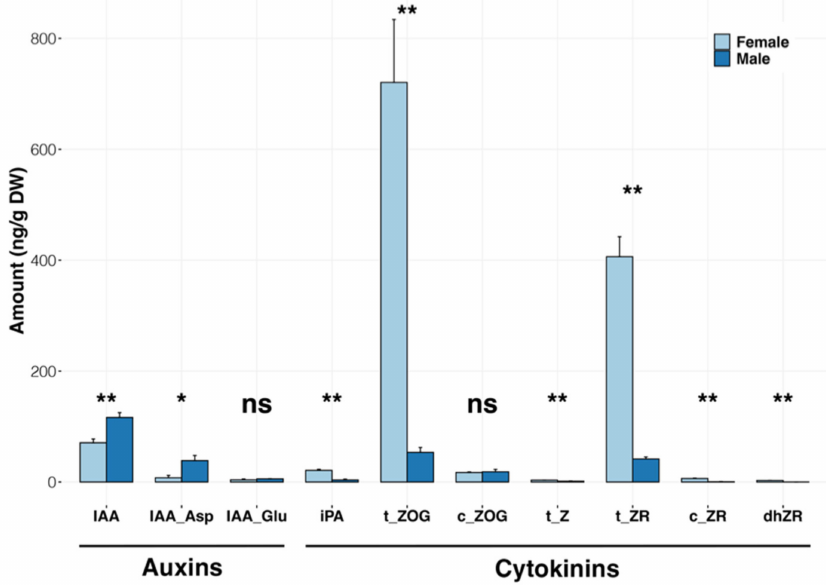
Figure 4. Analysis of the hormonal composition of oil palm male and female inflorescences.